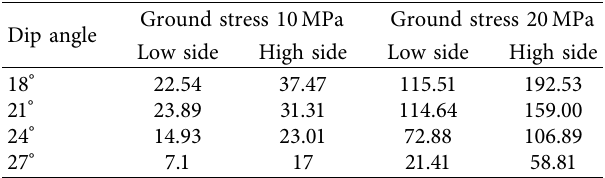
(Figure 11). The geometric similarity ratio is 1 : 30, the model size is 72 cm × 72 cm × 10 cm, and the lithology parameters are selected from the engineering background of the Shi- tanjing No. 2 mining area, which is the same as that for the numerical simulation. Different proportions of cement mortar were used to simulate the characteristics.